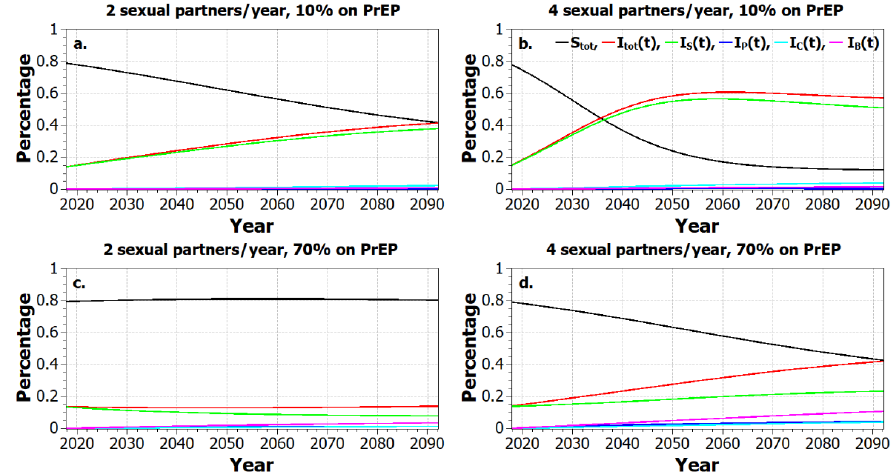
Figure 3. The optimistic scenario implies strict adherence to proper PrEP usage. These graphs show the total susceptible (black line) and infected (red line) percentages as a function of time. In addition, the breakdown into the detailed makeup of each category is presented with the legend as shown in ( b ), where S tot is the total number of susceptibles, I tot is the total infected, I S is the portion of I tot using no prophylaxis, I P is the portion of I tot using only PrEP, I C is the portion of I tot using only condoms, and I B is the portion of I tot using both PrEP and condoms. ( a ) Projection when 10% of the population is using PrEP and the average number of sexual partners is two. ( b ) Projection when 10% of the population is using PrEP and the average number of sexual partners is four. ( c ) Projection when 70% of the population is using PrEP and the average number of sexual partners is two. ( d ) Projection when 70% of the population is using PrEP and the average number of sexual partners is